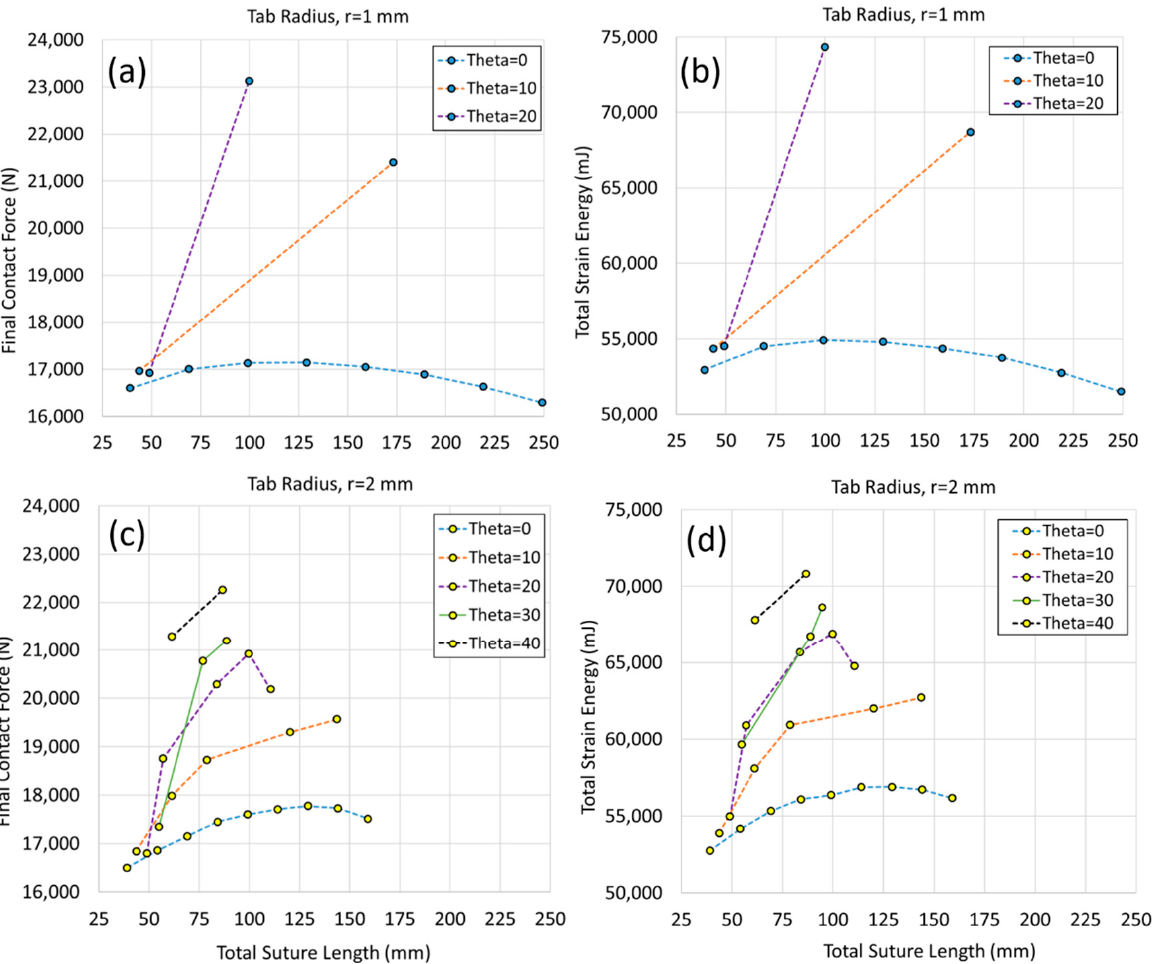
Figure 10. Final contact force and total strain energy for archways with a suture tab radius of 1 mm ( a , b ) and 2 mm ( c , d ) as a function of the total suture length.